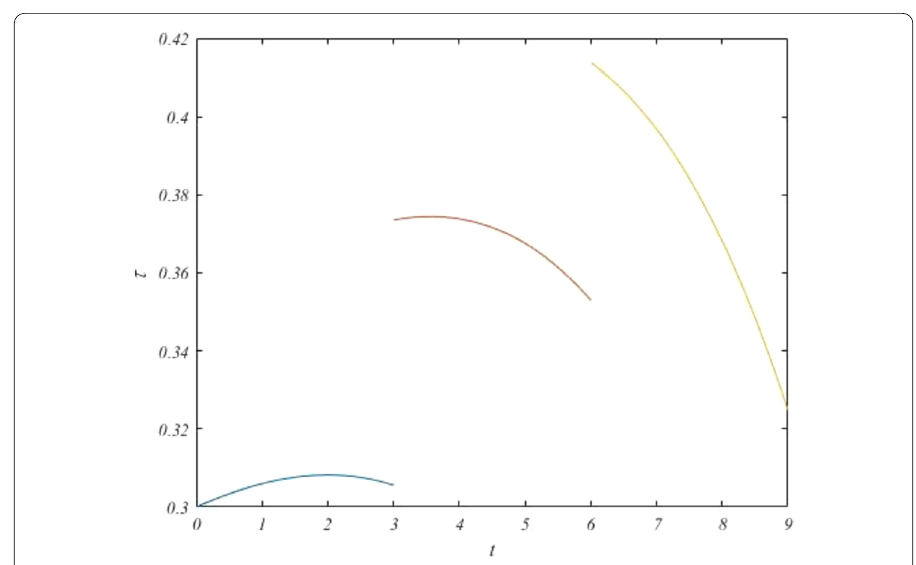
Figure 2 Solution with impulsive tagging. Time series of the density of tagged fish at the spatial position x = 0, with impulsive tagging at the times t = k (cid:2) t , (cid:2) t = 3, k = 1,2,3,4, ... . Here, c = 0.1, A = 1, B = 1, C = 0.3, D = 1.25, u = 0.05, τ 0 = 0.3, s 0 = 0.64, κ = 0.25, p = 0.2, ρ = 0.02, and t 0 =